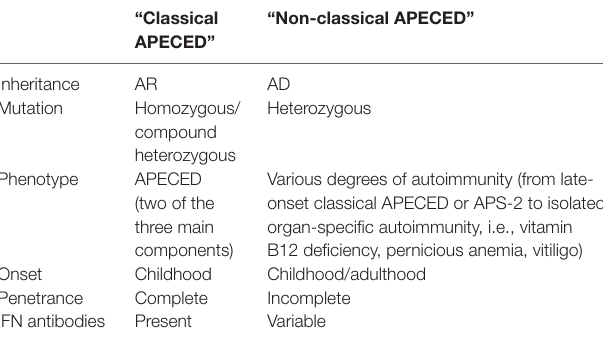
TABLe 1 | APeCeD in “classical” and “non-classical” forms. “Classical